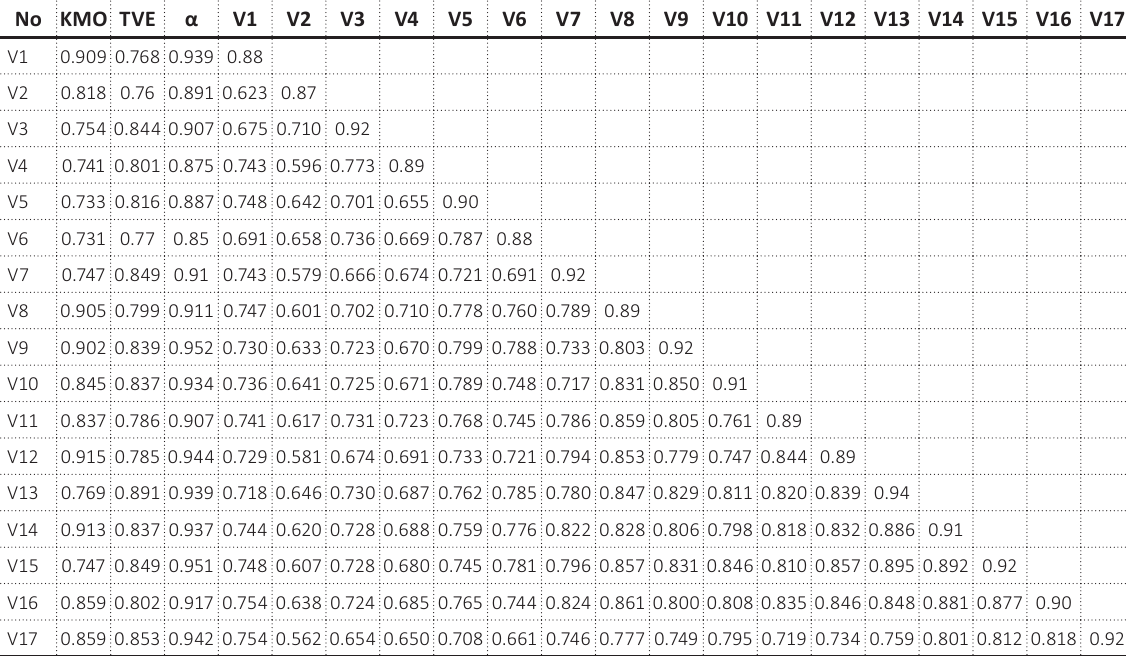
Table 1. Reliability, discriminant and convergent validity of factors measurements